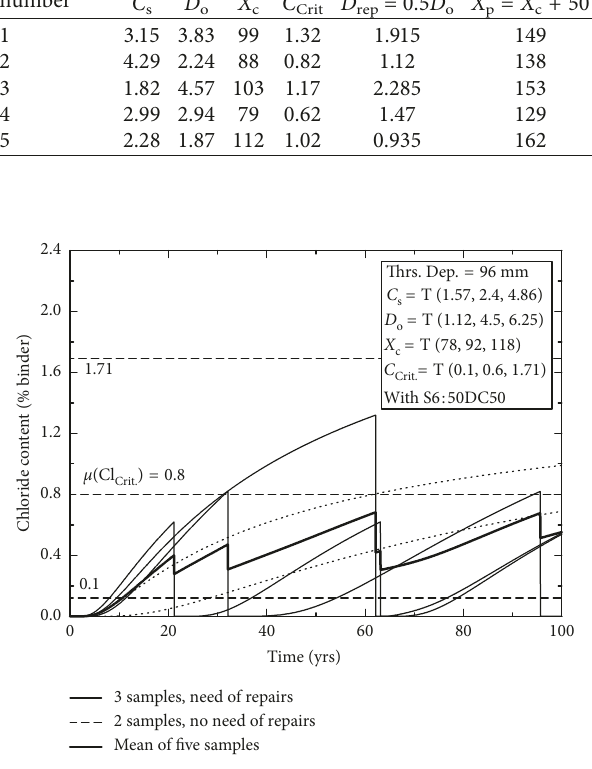
Figure 6: Probabilistic time-dependent chloride profiles based on five sets of random samples.